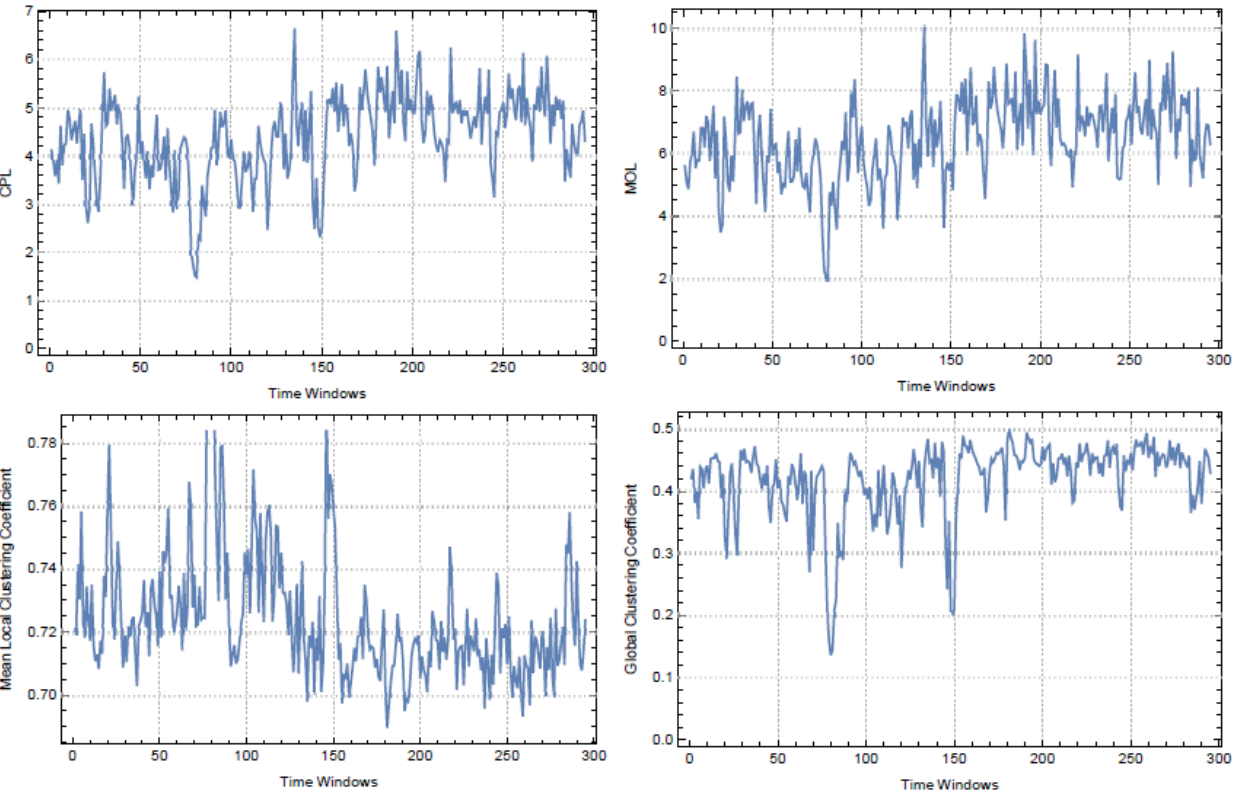
Figure 2. CPL and MOL measures for Maximal Spanning Trees, weighted local and global clustering coefficients of G j for FTSE100. T